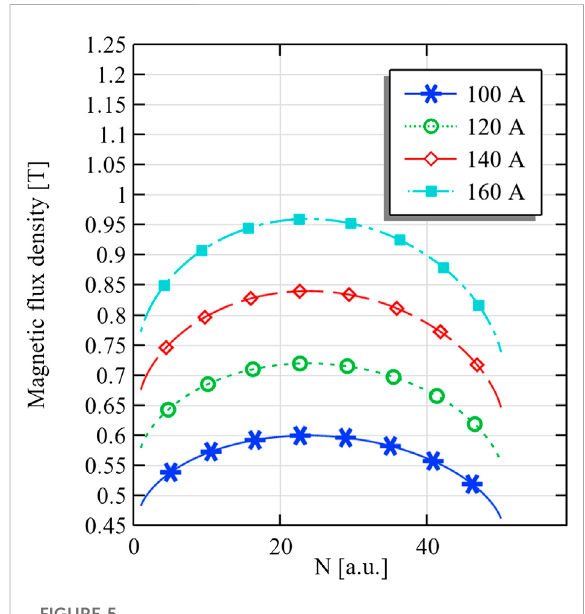
FIGURE 5 The magnetic fl ux density versus the turn of the pancake coil at the